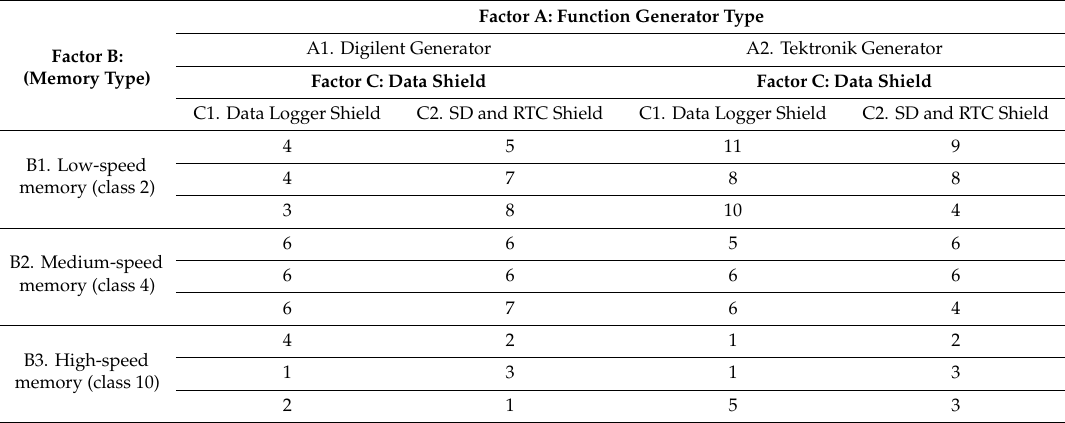
Table 4. Data extracted from the experiment. Output variable: number of blackout events; Factor A: